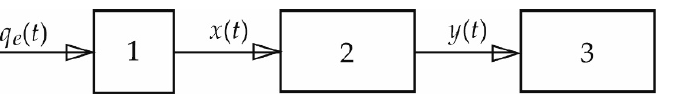
Figure 1. Simplified block diagram of the electrical quantities measuring line. 1—electrical quantity sensor (current or voltage), 2—analog filter, 3—measuring-and-controlling device.